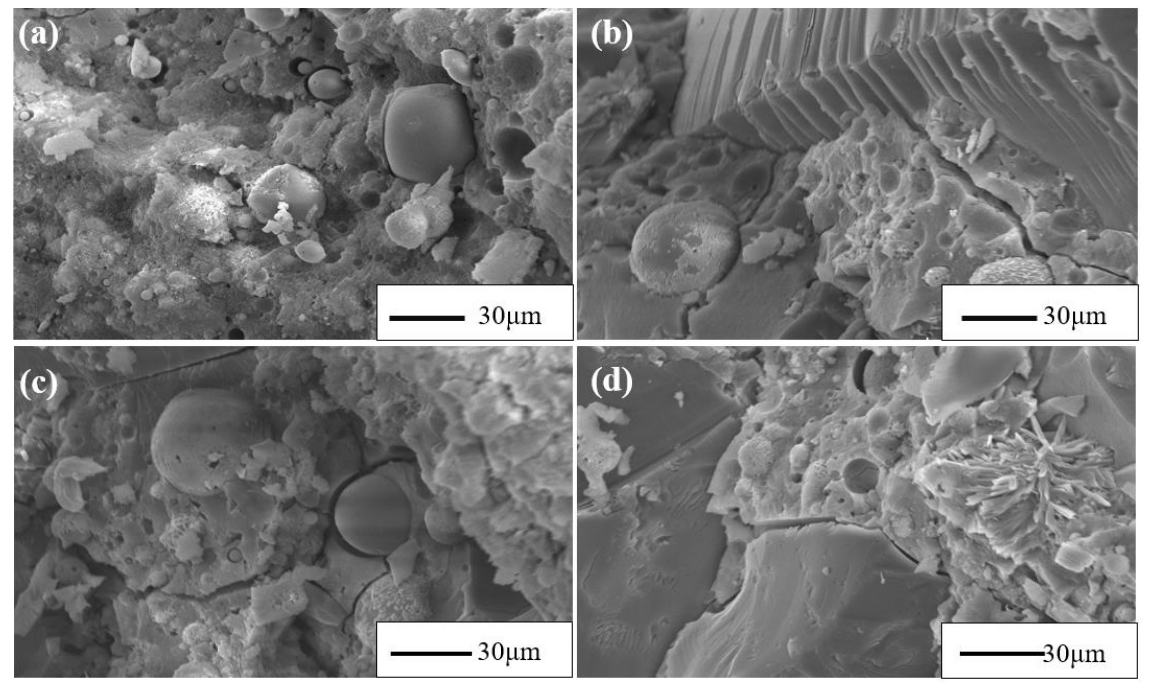
Figure 17. SEM images of different recycling glass contents (( a ) T30G0, ( b ) T30G10, ( c ) T30G20, ( d ) T30G30).